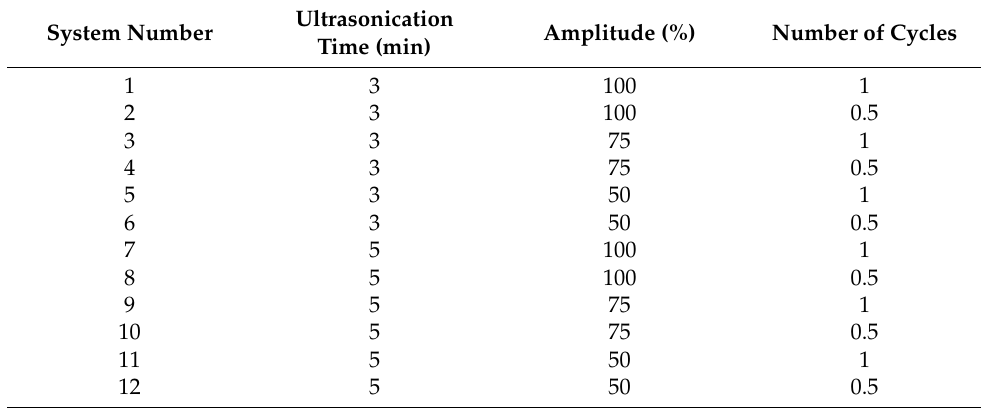
Optimization parameters for solid lipid nanoparticles prepared by the ultrasonic- nanoemulsification